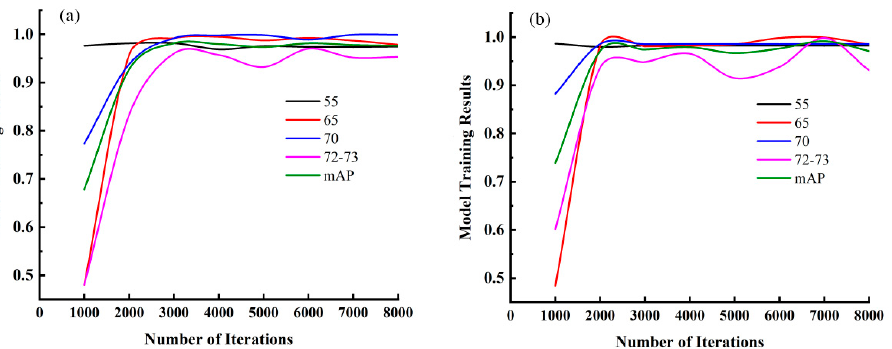
Figure 6. Abscissa represents the number of model iterations; ordinate represents the model training results, and different colors represent different types of bauxite. The left figure ( a ) represents the training results of the unbalanced datasets, and the right figure ( b ) represents the training results of the balanced datasets.